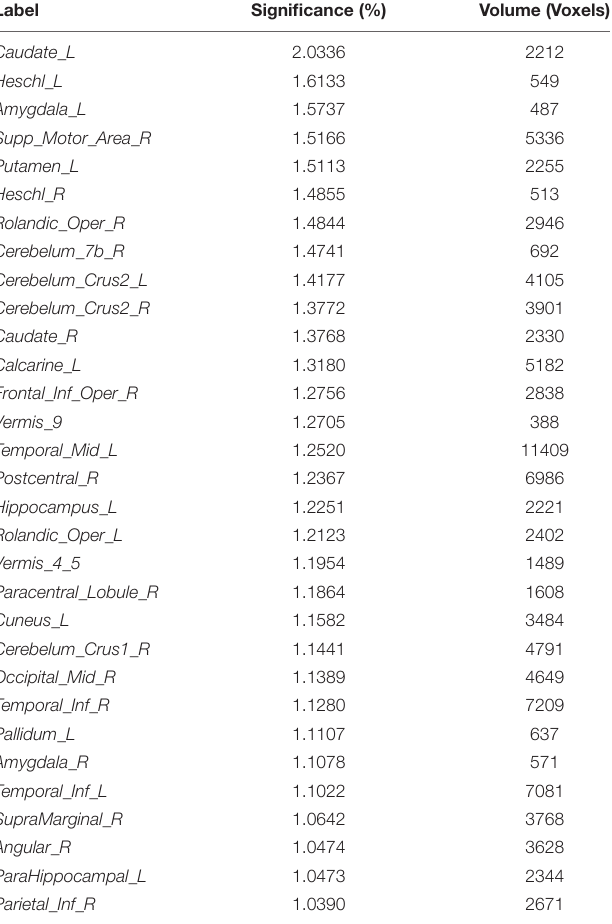
TABLE 2 | ROI weights and voxel sizes of the circuit predicting the CTQ-Sexual abuse for BPD. Label Significance (%)